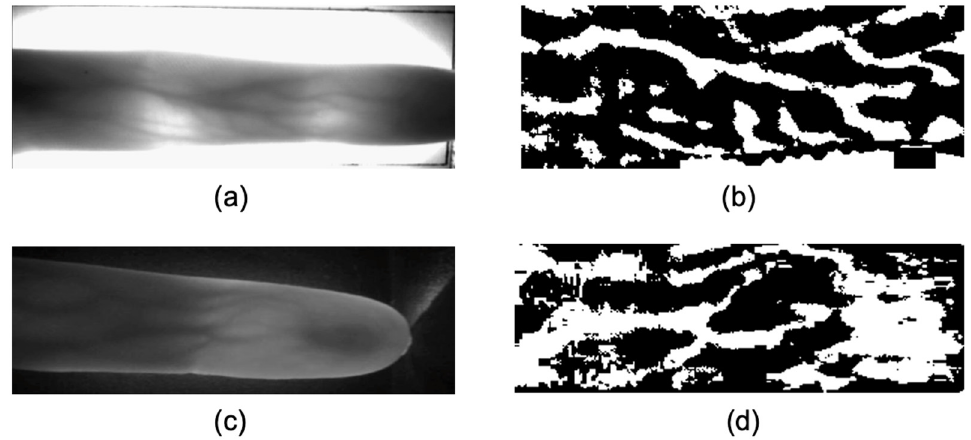
Figure 3. Sample images of the finger vein databases used in our research. ( a ) Original image of HKPU, ( b ) preprocessed image of HKPU, ( c ) original image of FVUSM, and ( d ) preprocessed image of FVUSM.